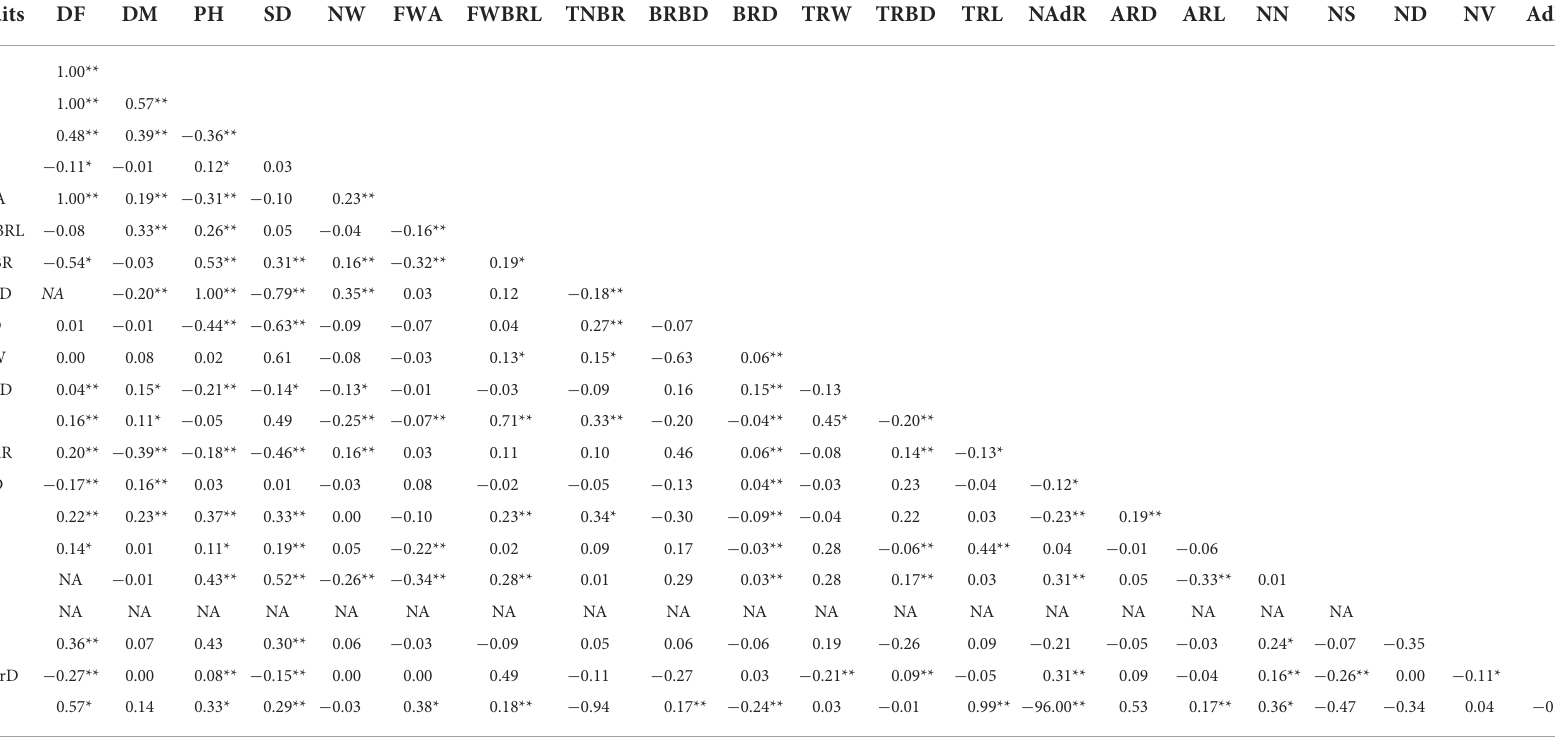
TABLE 3 Genotypic correlations among cowpea grain yield and root phenotype traits.